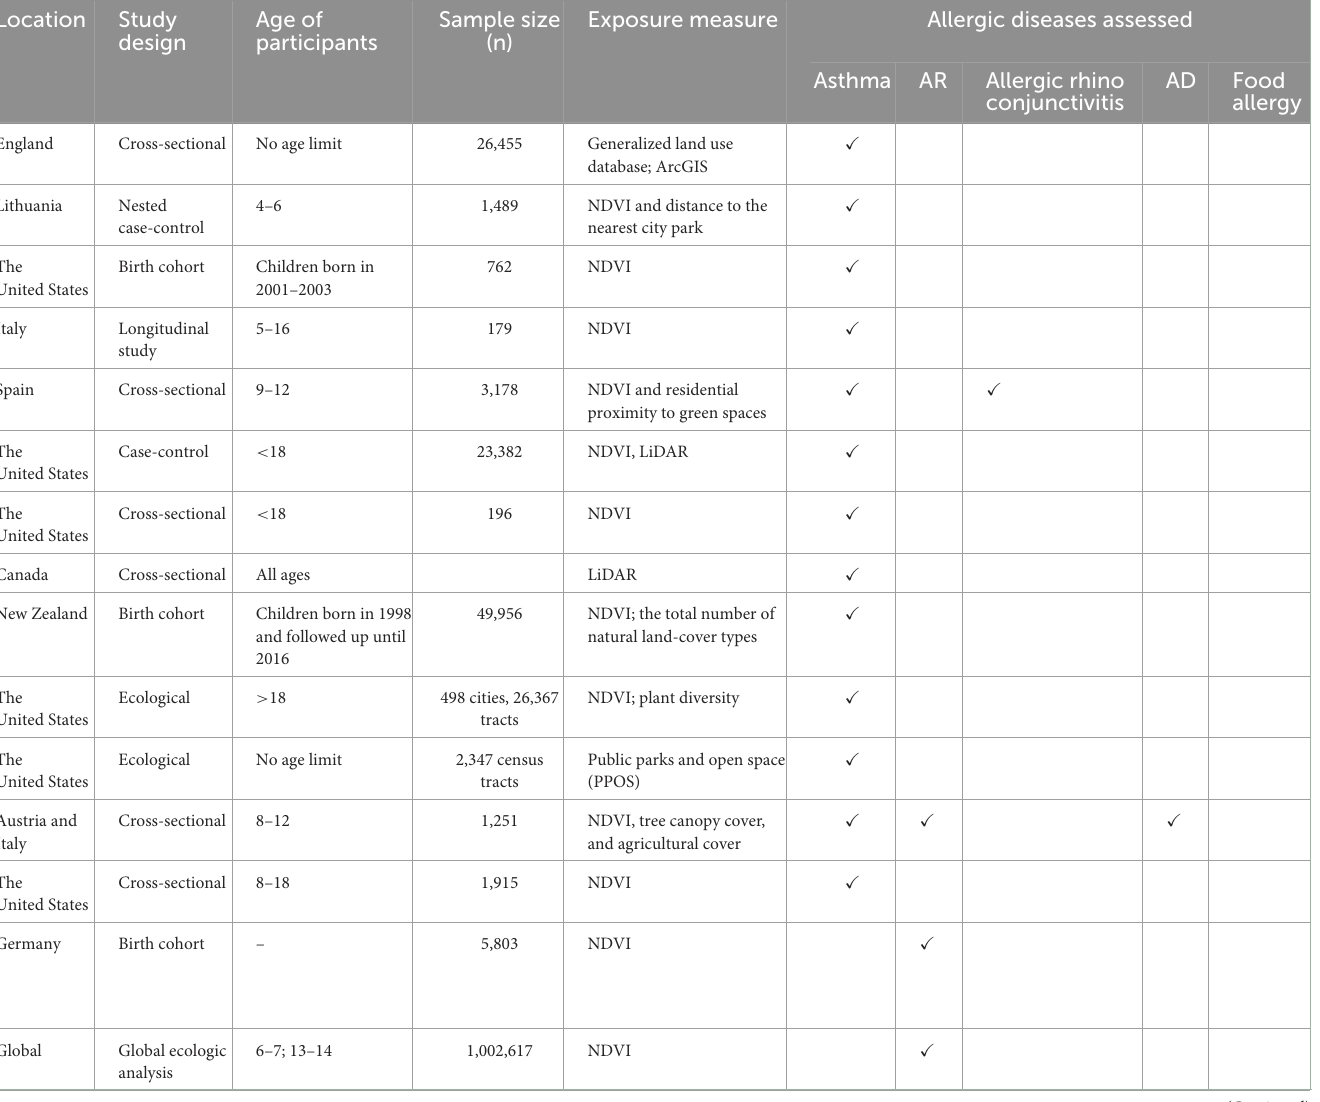
TABLE 1 Characteristics of the included